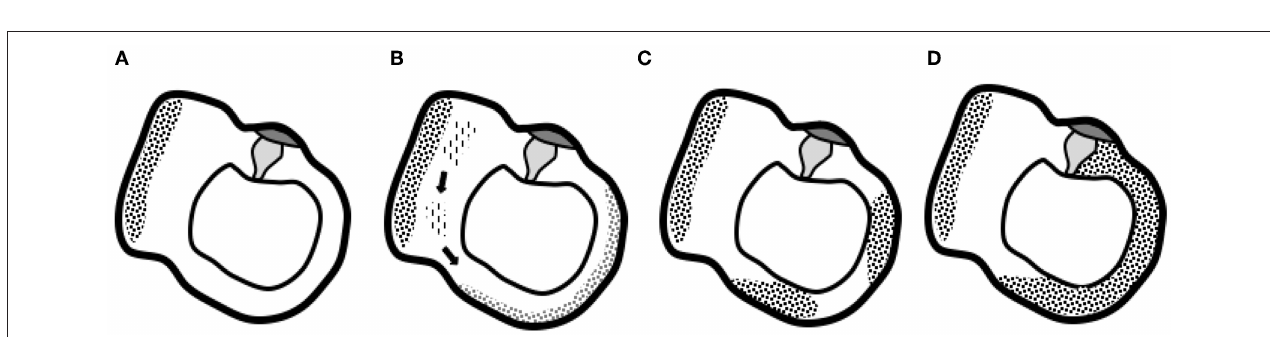
FIGURE 3 | A bar plot illustrating the percentages of the affected semicircular canals on CT and MRI.